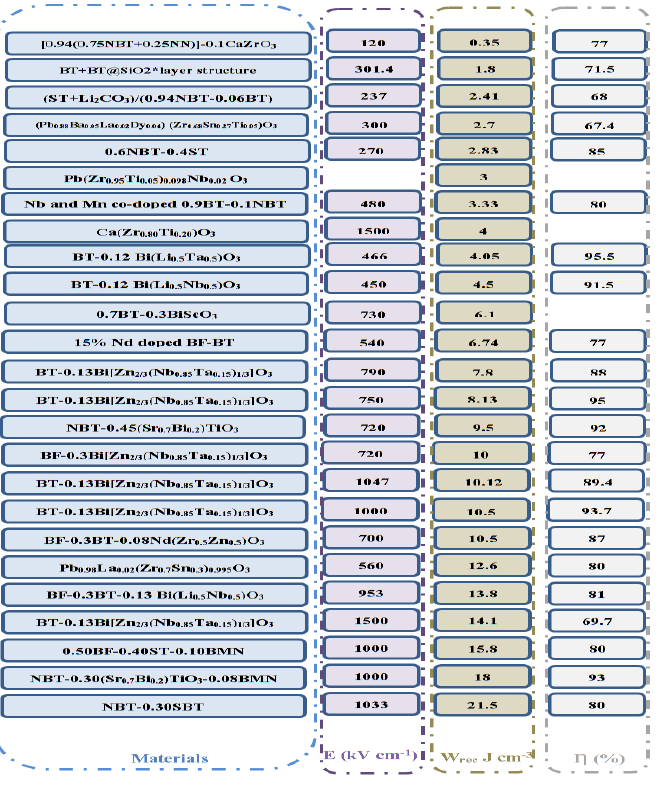
Figure 5. ( a ) Temperature [78] and ( b ) frequency-dependent [79] Wrec for some reported electro- ceramic materials for high-energy-density capacitors.